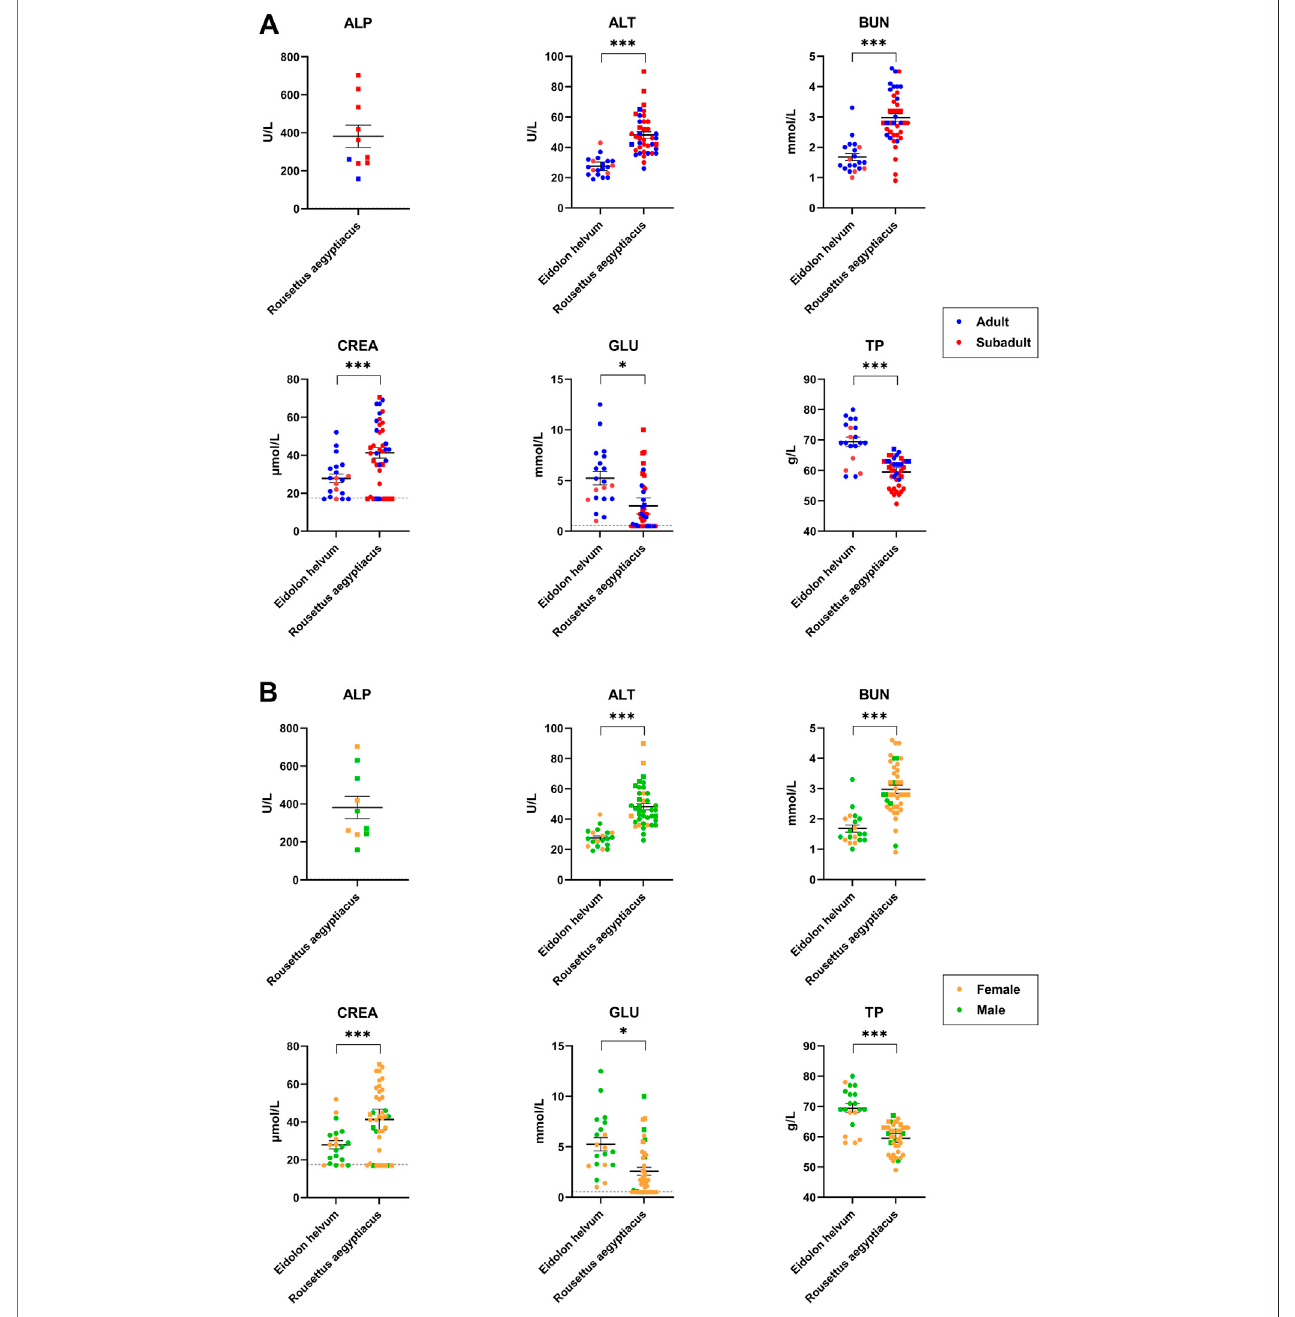
FIGURE 4 | Age- and sex-dependent variations of clinical blood chemistry parameters in R. aegyptiacus and E. helvum. Single dots represent one animal (adult/ subadult) in (A) and (female/male) in (B) . The same cohort was used for comparison. Dotted lines represent the lower detection limit. Solid horizontal bars represent mean ± SEM. Note that ALP could only be determined for 10 R. aegyptiacus bats. Statistically signi fi cant differences were determined for clinical blood chemistry parameters (ALT, BUN, TP, ALP, CREA, GLU), * = signi fi cant: p -value < 0.05; *** = extremely or highly signi fi cant: p -value < 0.001.